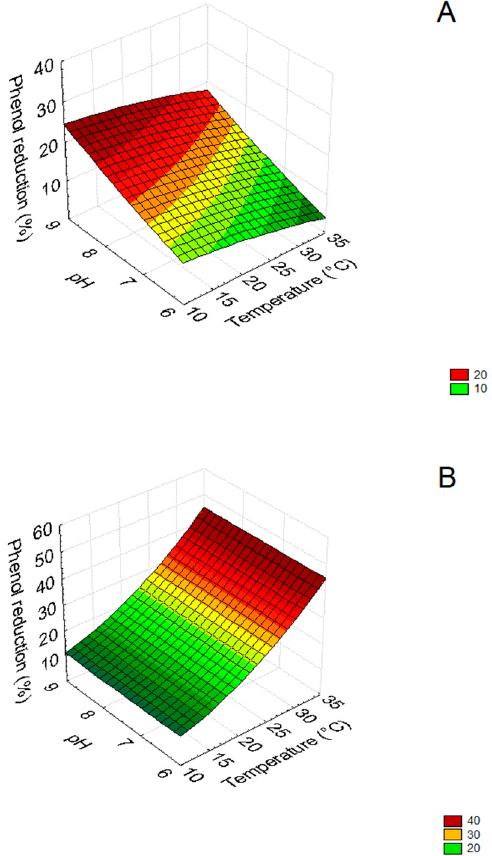
Figure 4. 3D plots for the interaction pH/temperature on phenol reduction (test 1: inoculum of C. boidinii followed 3 days after by B. pumilus ) in FTOPW (fresh table olive processing water) after 3 days. Test C of Table 3.